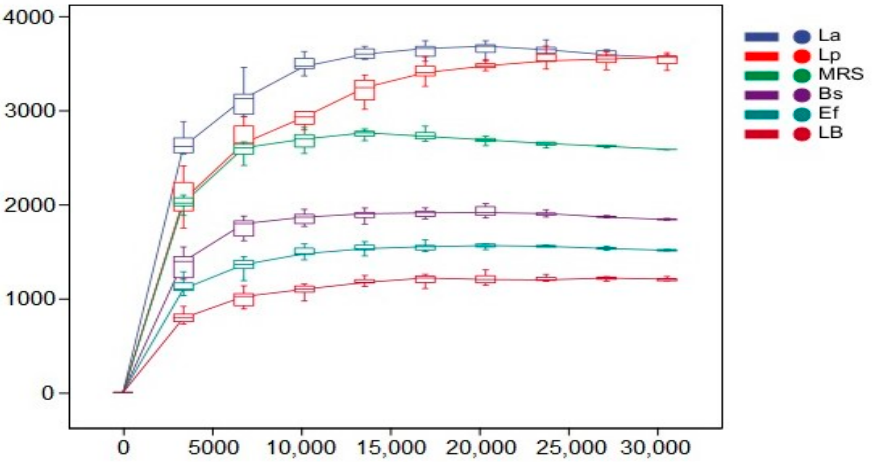
Figure 4. Dilution curves of the six sets of samples. Horizontal coordinates indicate the depth of sequencing, and vertical coordinates indicate the total number of species detected in the samples.